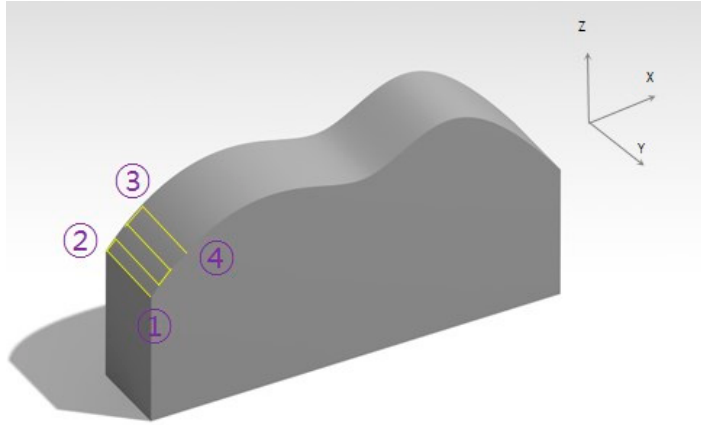
Figure 2. Schematic diagram of contour milling. (The sequence of tool paths are 1, 2, 3 and 4) .